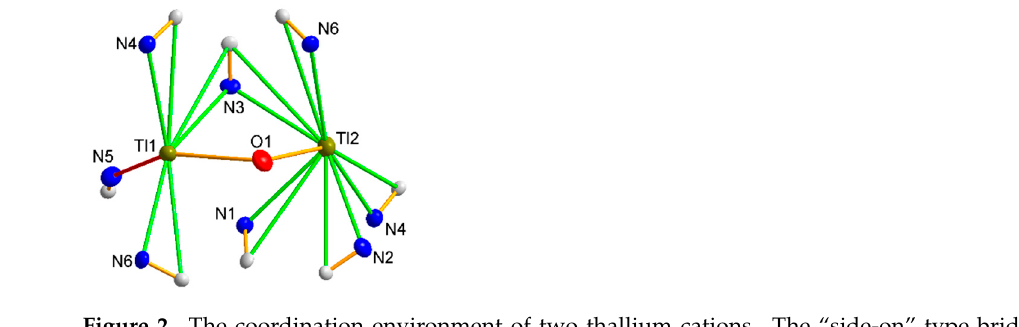
Figure 2. The coordination environment of two thallium cations. The “side-on” type bridging interactions are marked in green, and the “end-on” type in red. All H atoms are omitted for clarity. All atoms shown are represented at 30% probability thermal ellipsoids.